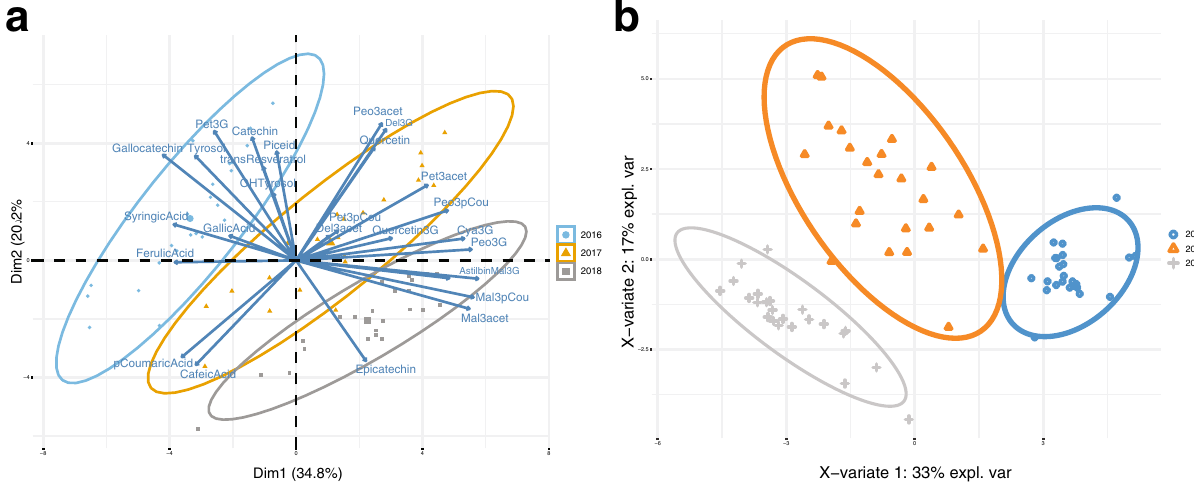
Figure 2. ( a ) Principal component analysis biplot of combined PCs measured in individual fermentation replicates of Malbec wines from the 2016, 2017 and 2018 vintages. Ellipses that overlap are not significantly different from one another at the 95% level. ( b ) PLS-DA plot for the vintages. Samples of 2016 are represented with color blue, 2017 with orange, and 2018 with grey. Legend: Del3G = Delphinidin 3- O -glucoside, Cya3G = Cyanidin 3- O -glucoside, Pet3G = Petunidin 3- O -glucoside, Peo3G = Peonidin 3- O -glucoside, Mal3G = Malvidin 3- O -glucoside, Del3acet = Delphinidin 3- O -acetylglucoside, Pet3acet = Petunidin 3- O -acetylglucoside, Peo3acet = Peonidin 3- O -acetylglucoside, Mal3Acet = Malvidin 3- O -acetylglucoside, Pet3pCou = Petunidin 3- O - p -coumaroylglucoside, Peo3pCou = Peonidin 3- O -p-coumaroylglucoside, Mal3pCou = Malvidin 3- O - p -coumaroylglucoside, GallicAcid = Gallic acid, OHTyrosol = OH-tyrosol, Tyrosol = Tyrosol, Catechin = (+)-Catechin, SyringicAcid = Syringic acid, Epicatechin = (−)-Epicatechin, Astilbin = Astilbin, CafeicAcid = Caffeic acid, pCoumaricAcid = p -coumaric acid, FerulicAcid = Ferulic acid, Piceid = trans -piceid, transResveratrol = Trans -resveratrol, Quercetin3G = Quercetin-3-glucoside, Quercetin = Quercetin, Gallocatechin = (−)-Gallocatechin. The figure was generated using Adobe Illustrator, version 22.1.0 (https ://www.adobe .com/produ cts/illus trato r.html), Rpackage factoextra—‘factoextra’ and R-package